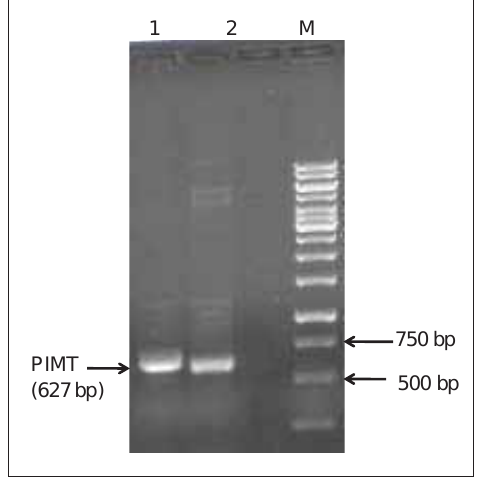
Figure-2: Polymerase chain reaction (PCR) amplification of Salmonella Typhimurium protein L-isoaspartyl O-methyl transferase using plasmid DNA template. The amplified products were analysed on 1% agarose gel. Lane M: 1 kb DNA ladder, Lane 1 and 2: PCR amplified products marked by